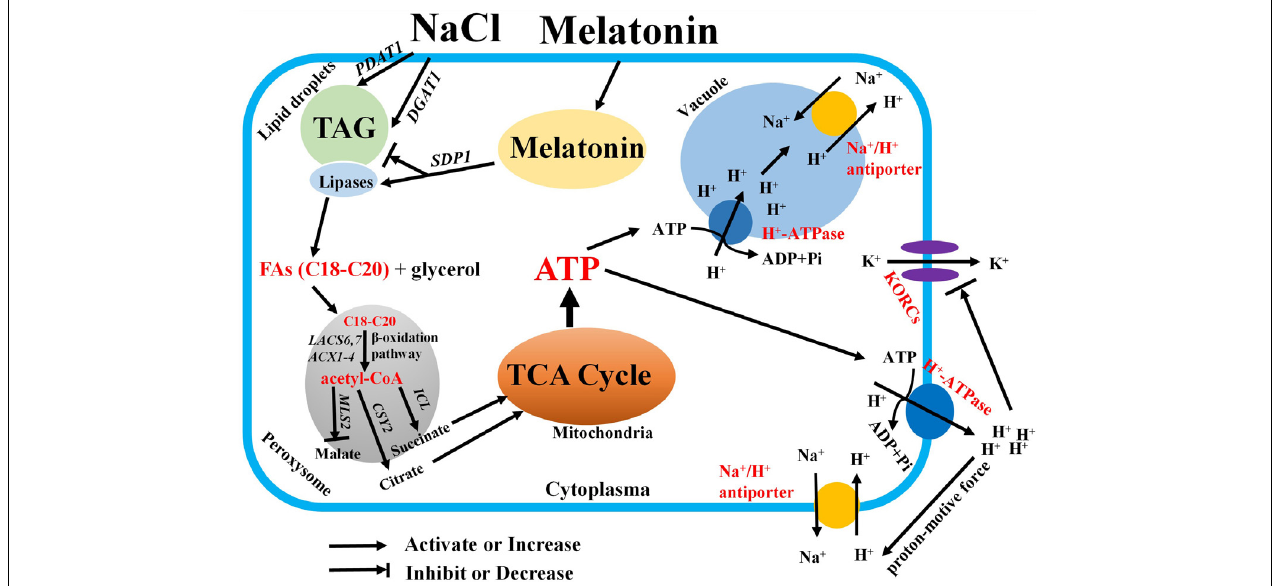
FIGURE 8 | Schematic model showing the mediation of MT on salt tolerance in sweet potato. In this model, MT recovers the inhibitory effects of salt stress on the expression of SDP1 and lipase activity and accelerates FA release from TAG. Thus, several free FAs with appropriate acyl chain are transported to the peroxisome for β -oxidation. The resulting acetyl-CoA is used for catalyzing the production of succinates and citrates by isocitrate lyase and citrate synthase. Then, succinate and citrate enter the mitochondria for the TCA cycle. Thus, abundant ATPs were generated for driving the activity of H + –ATPase across the PM and tonoplast. Therefore, the increased PM H + –ATPase activity blocks the K + efflux via depolarization-activated K + outward channels. In addition, the Na + /H + antiport activity across the PM and tonoplast is fuelled by the generated proton motive force. Finally, the K + /Na + homeostasis is maintained under salinity